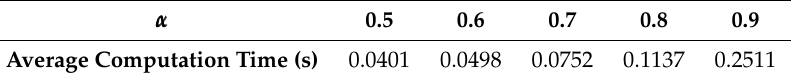
Figure 3. RMSE (root mean square error) versus different values of the parameters α and Q . Table 1. Average computation time for different values of the parameter α .